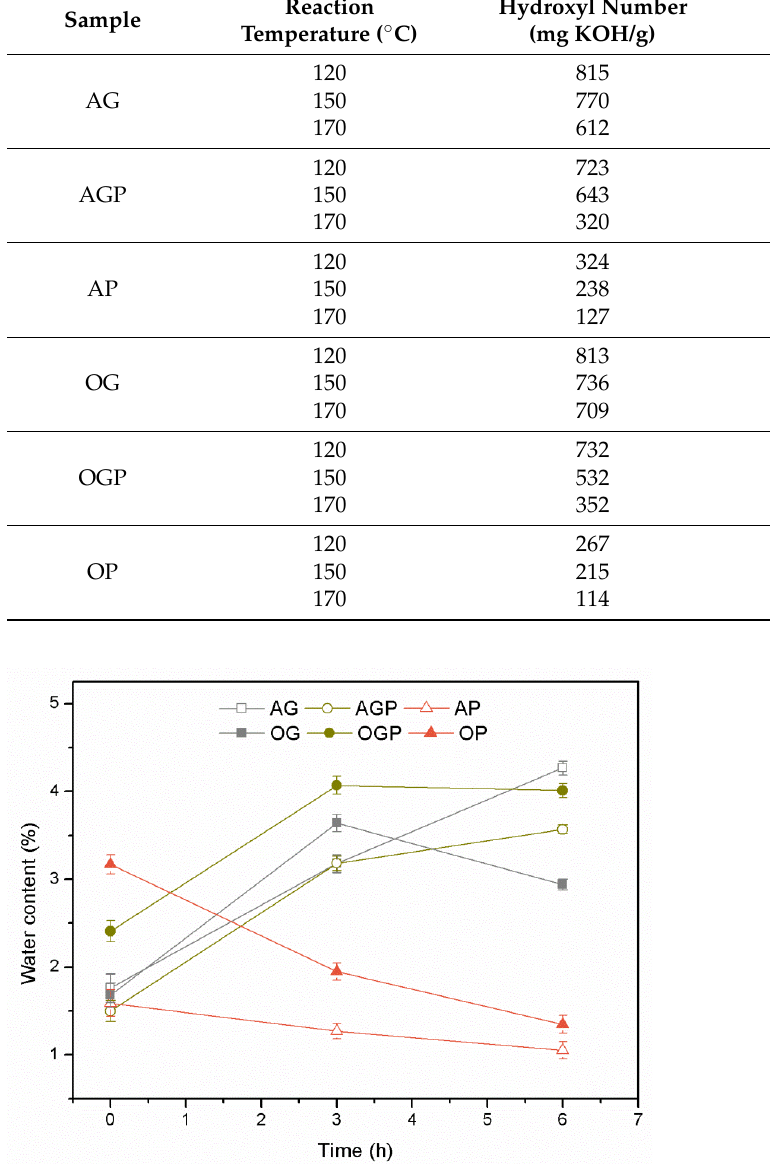
Figure 2. Water content in bio-polyols depending on the time of the liquefaction